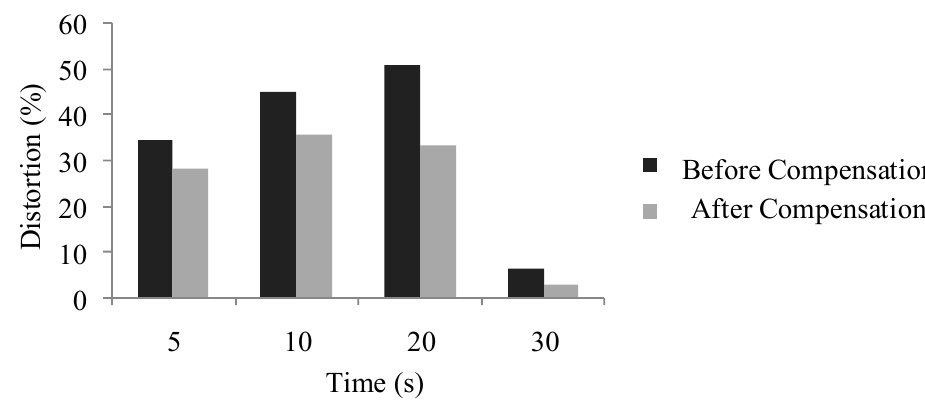
Figure 9. Flow nonlinear compensation control.